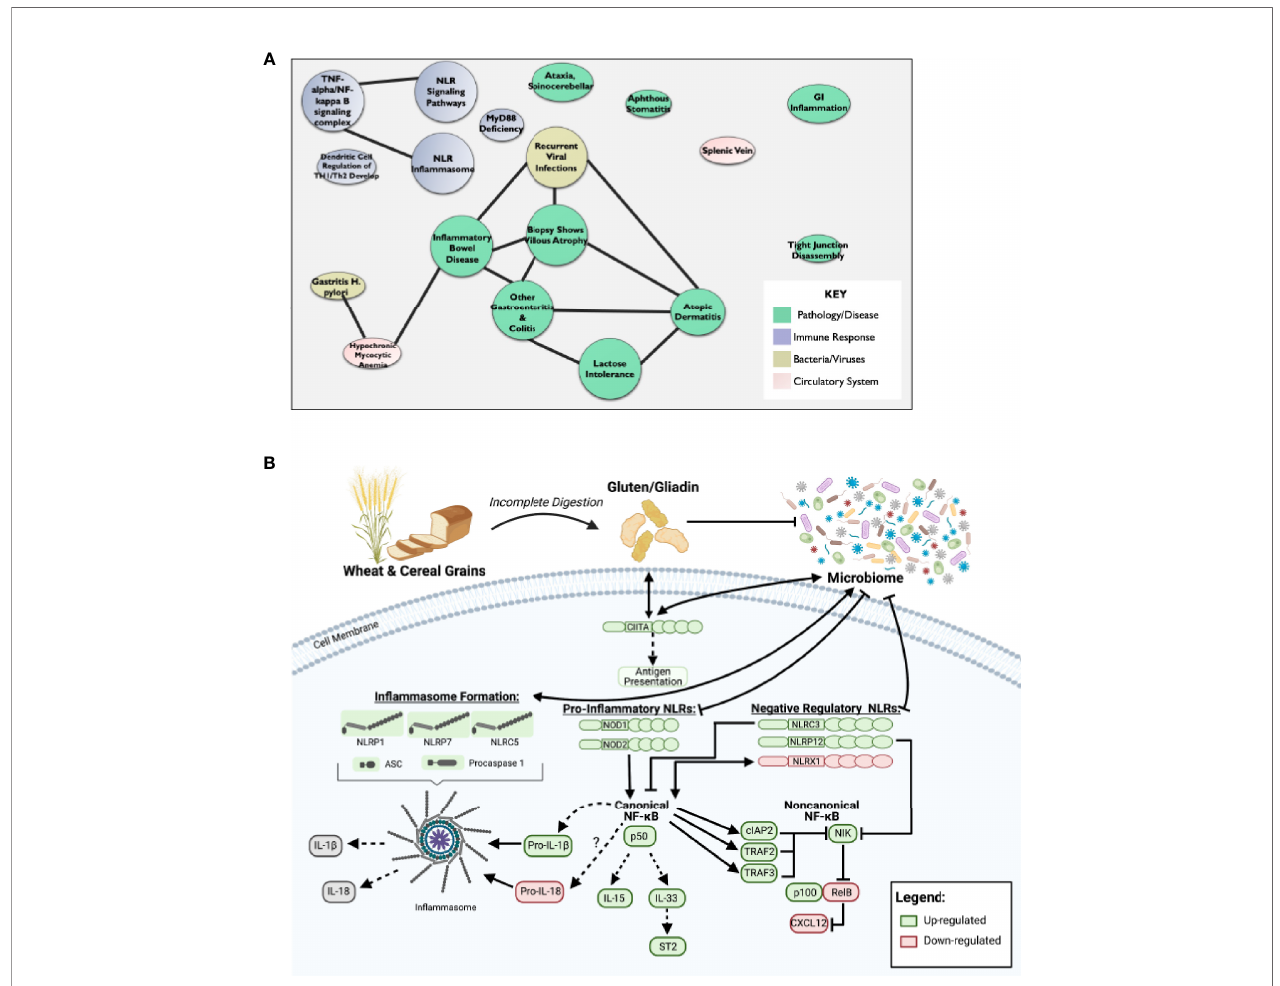
FIGURE 2 | Dysregulation of NF- k B Pathway Downstream of Impaired NLR Signaling May Potentiate CeD Pathogenesis. (A) CompBio AI algorithm predicted increased NF- k B/TNF signaling, NLR in fl ammasome signaling, and regulatory NLR signaling that is consistent with CeD pathology. (B) Schematic representative of IPA data output predicts that partial digestion of gluten is recognized as a DAMP by PRRs to signal NLRs in CeD. This results in downstream activation of canonical NF- k B and in fl ammasome formation, while inhibiting noncanonical NF- k